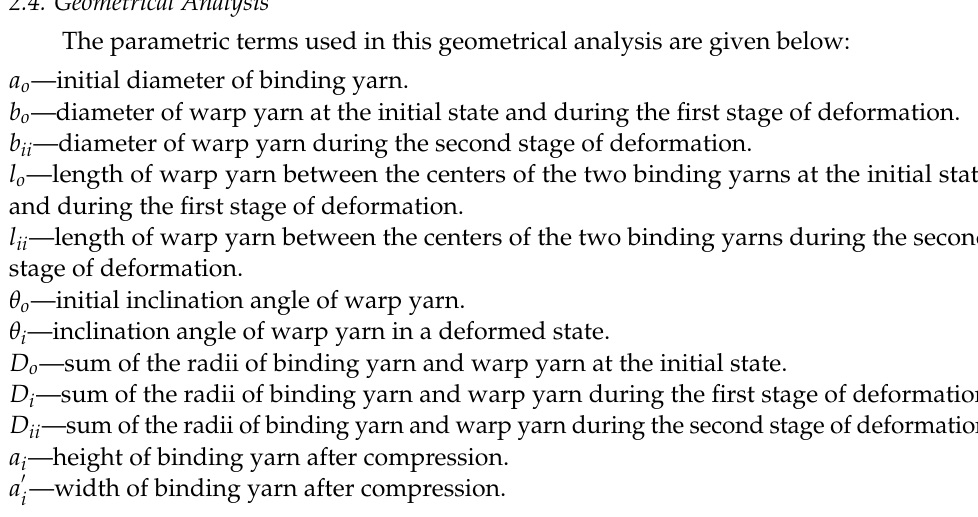
Figure 3. Binding yarn compression test